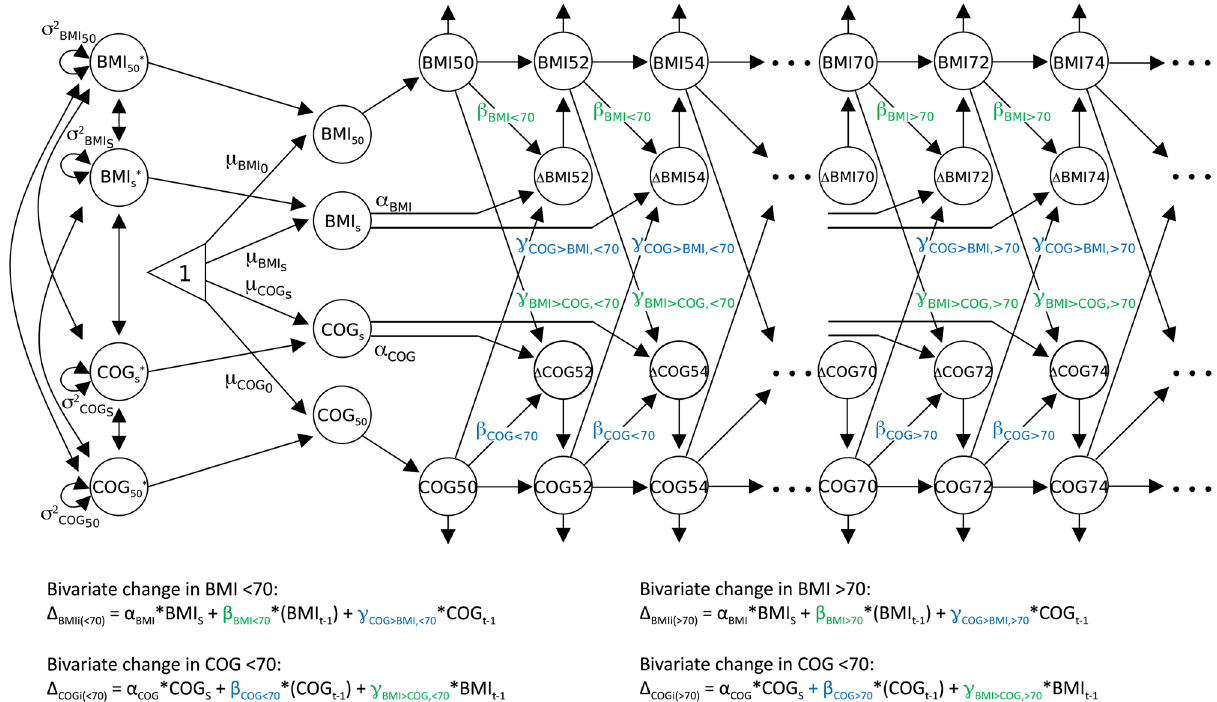
Figure 1. Path diagram of the bivariate dual change score model with two slopes, allowing for different rates of change before and after age 70. Body mass index (BMI) and cognitive abilities (COG) in each age category (BMI50, BMI52…; COG50, COG52…) are modeled. From the left, BMI 50 , BMI S , COG 50 , and COG S represent intercept level (at age 50) and slope of BMI and cognitive ability (asterisks represent their standardized scores), together with their estimated mean levels ( µ BMI 50 , µ BMI S , µ COG 50 , µ COG S ) and variances ( σ σ 2 COG ). α BMI and α COG represent the constant linear change related to the slopes, and β BMI and β COG represent S the proportional non-linear change. γ BMI>COG represent the coupling effect of BMI on cognition, and γ COG>BMI that of cognition on BMI. Univariate change in BMI at age = i, before age 70, is determined by the sum of the constant change in relation to the slope (α BMI * BMI S ) and the proportional change in relation to BMI level at the preceding occasion (β BMI<70 * BMI t−1 ). For bivariate change in BMI, considering the effect of cognitive ability, the additional coupling effect in relation to cognitive ability at the preceding occasion is added to the formula (γ COG>BMI, <70 * COG t−1 ). Univariate and bivariate change in BMI after age 70 and in cognitive abilities before and after age 70 is determined by the same formulas, using the corresponding